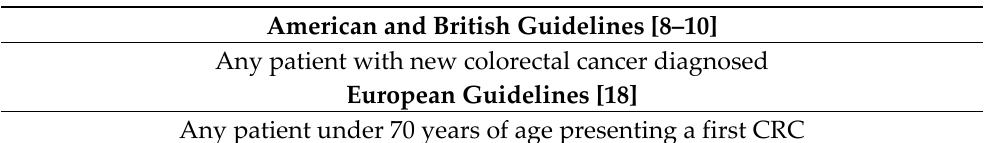
Table 2. Indications for immunohistochemistry (IHC) and/or microsatellite instability (MSI) test-